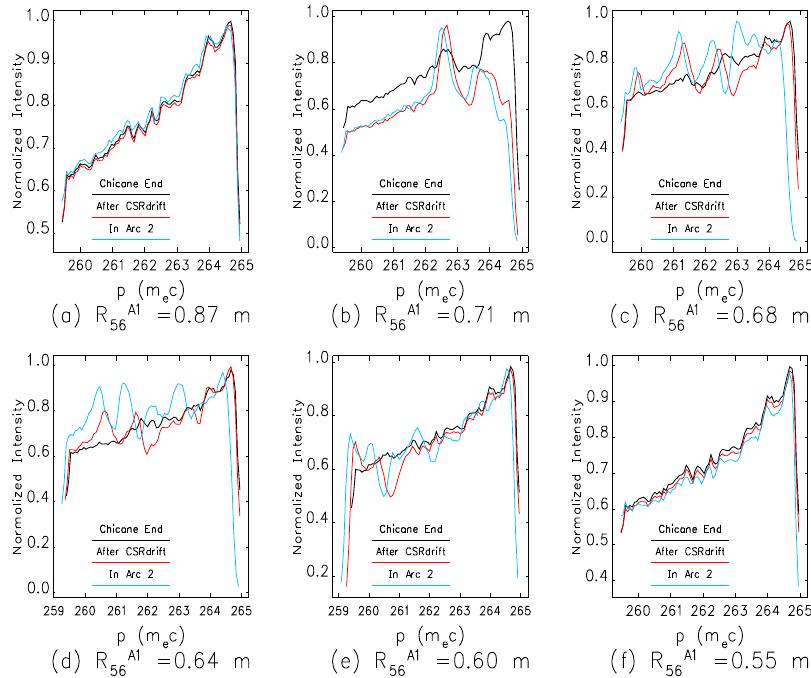
FIG. 6. Momentum spectra from simulation near full compression after the optical cavity chicane (BC1). The beam progresses from undercompression to overcompression in (a) – (f). The black line shows the spectrum immediately at the exit of the fourth dipole of the chicane, and the red line shows the spectrum after 4 m where CSR interaction with the bunch has continued. This interaction in the drift contributes significantly to the development of the spike and depletion regions.